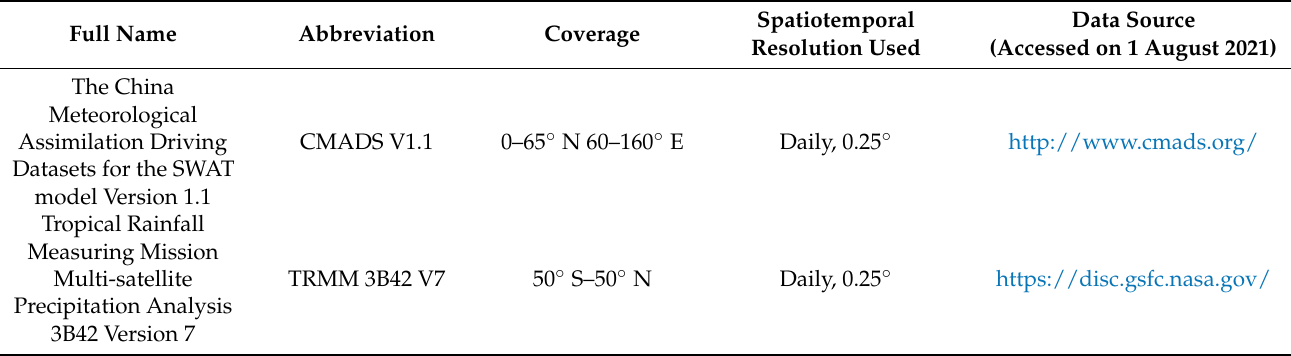
Table 2. Summary of remote-sensing/reanalysis precipitation